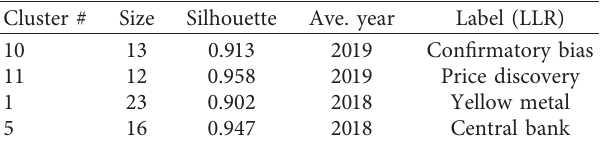
Table 7: Top five keywords in each recent cluster.